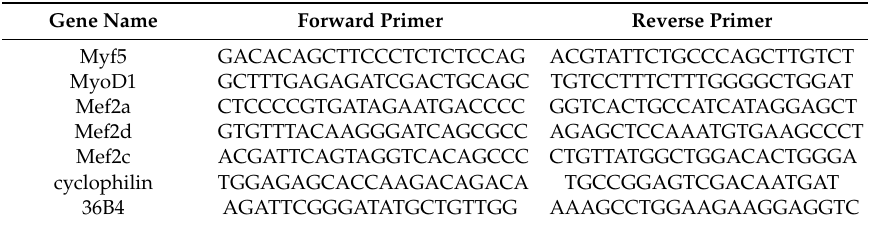
Table 3. Primers used in the